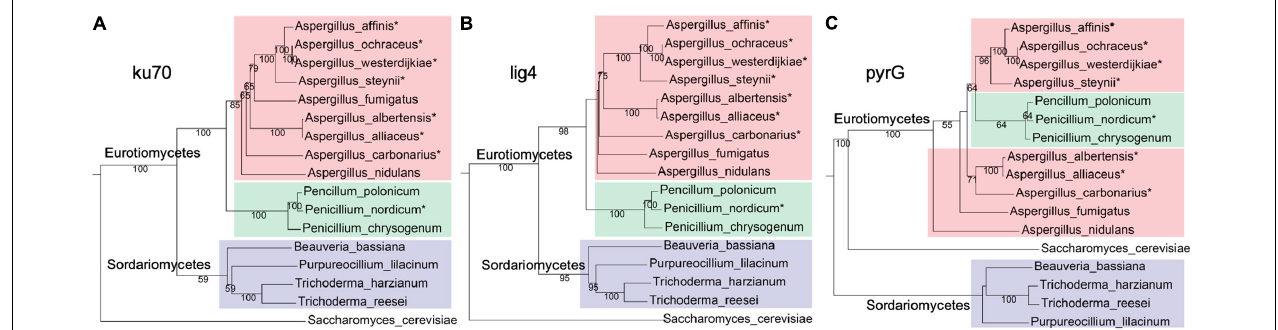
FIGURE 1 | Phylogenetic relationship homologs ku70 (A) and lig4 (B) and pyrG (C) , from fungi. The ochratoxin A (OTA)-producing fungi were marked with an asterisk. Red, green, and purple represent fungi from genus Aspergillus , genus Penicillium , and class Sordariomycetes , respectively. The protein sequences used in this analysis are listed in Supplementary Table 2